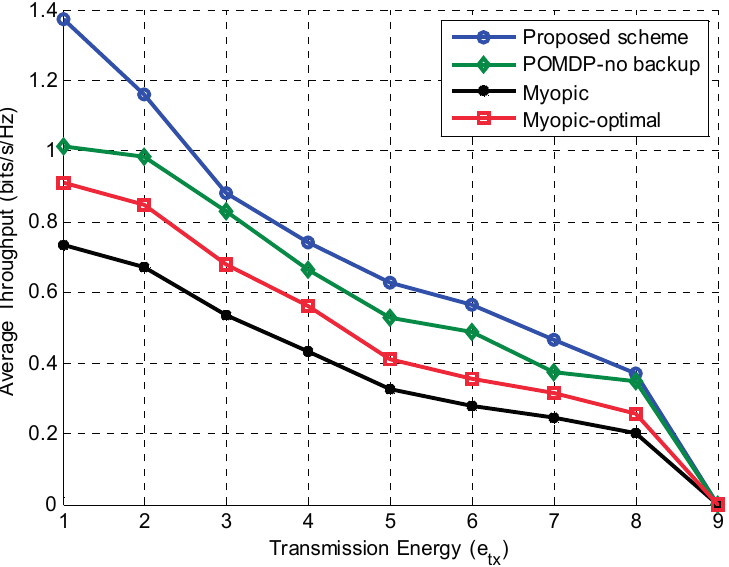
Figure 7. Throughput comparison of different schemes according to the transmission ) when (cid:1857) energy ( (cid:1857) = 10 (cid:3047)(cid:3051) (cid:3040)(cid:3028)(cid:3051)